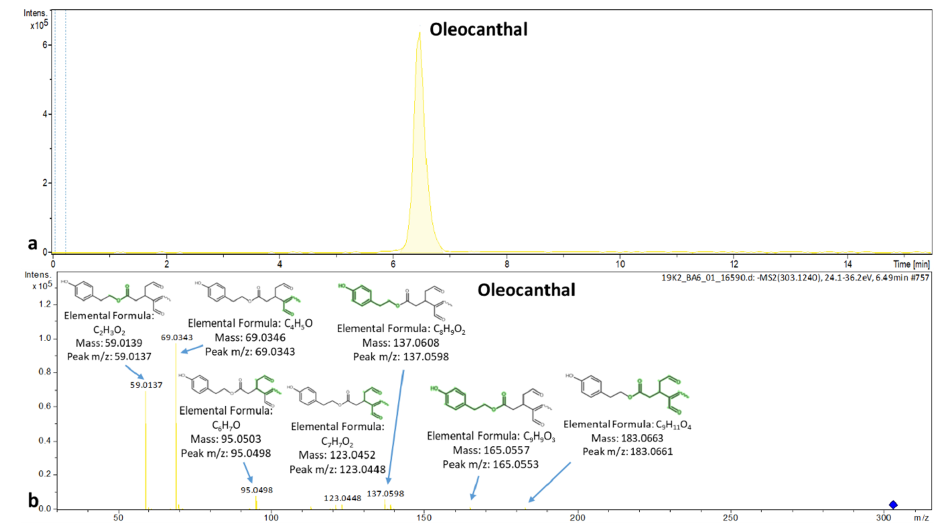
Figure 13. Extracted ion chromatogram and MS/MS spectrum of oleocanthal in drupes.